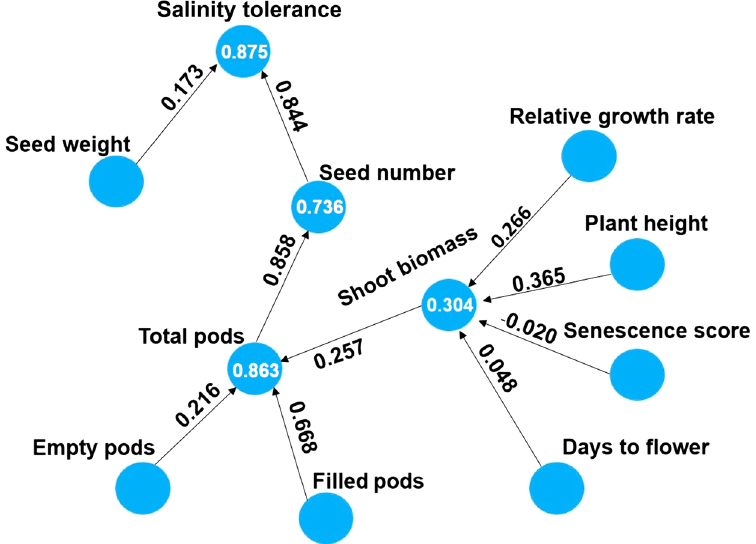
Figure 5. Path analysis diagram of seed yield and yield components. Path analysis derived from structural equation modelling using Partial Least Squares Algorithm method developed by Wold 44 to demonstrate complex relationship existing between salinity tolerance (seed yield under salt/seed yield under control) and yield related traits. Path coefficients indicated with values on the arrows show direct effect between different yield related traits. Regression coefficients are indicated by values in the circles. Values used for path analysis are relative measurements